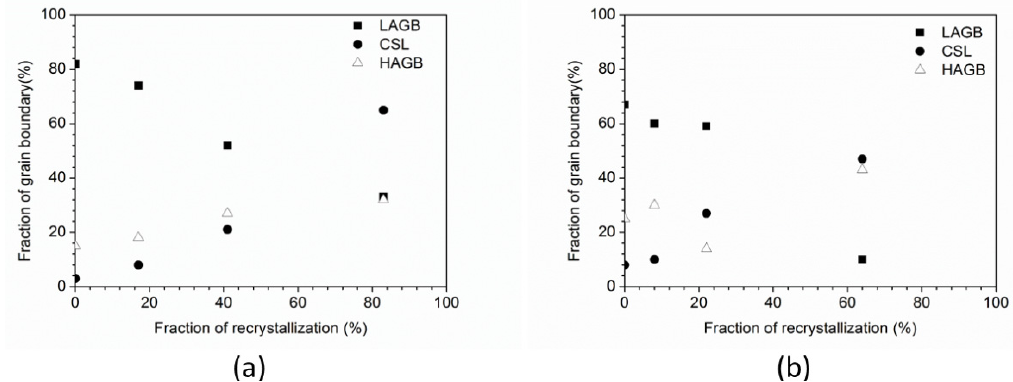
Figure 7. Fraction of grain boundaries as a function of recrystallization fraction for ( a ) 50% and ( b ) 90% cold-rolled FePd alloy at 700 °C. (LAGB: Low-angle boundary with misorientation between 5° and 15°, HAGB: High angle boundary with misorientation >15° and CSL: Coincidence site